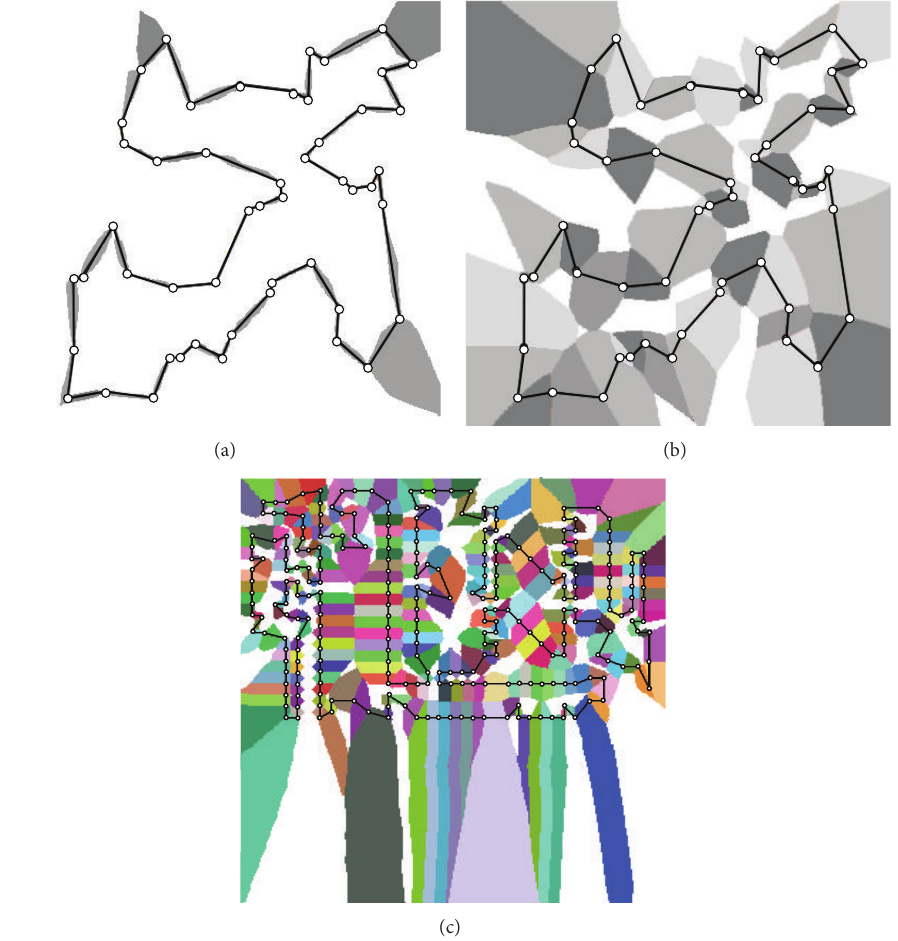
Figure 2: Examples of adaptive stability areas for integer Euclidean TSP; 𝑋 = 1, 400 × 1, 400 ; (a) SASA and (b) ASA of the optimal tour passing through 50 uniformly distributed points; (c) ASA for the instance a280 (drilling problem) from TSPLIB [19].